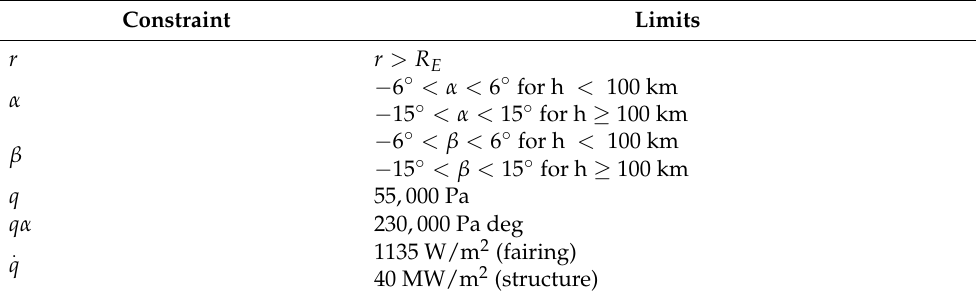
Table 9. Limits on the nonlinear